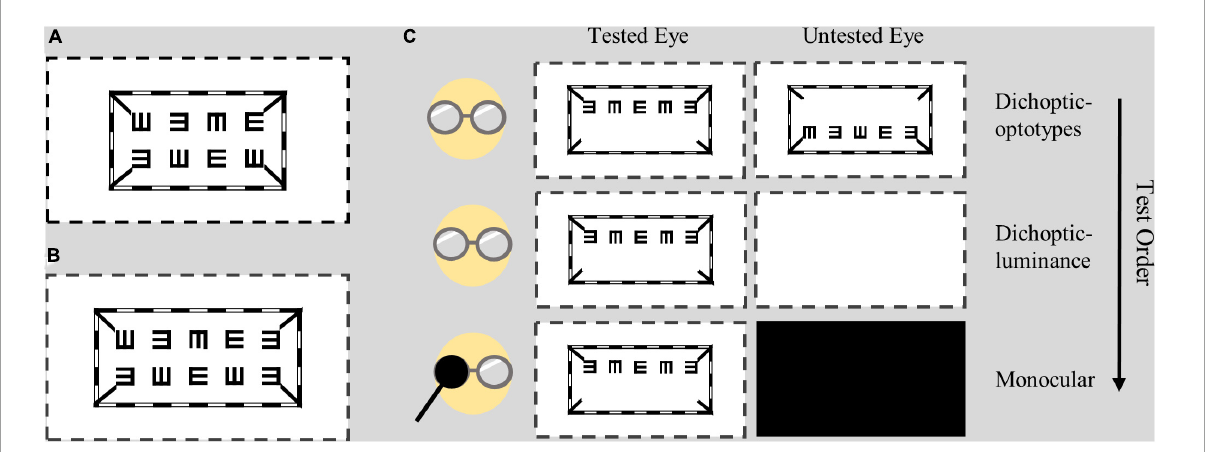
FIGURE1 Design of the dichoptic visual acuity chart. Two lines of E letters were presented to different eyes, while the envelope and four short lines were presented to both eyes. (A) In Experiment 1, each line had four letters with a letter representing 0.025 logMAR. (B) In Experiment 2, each line had five letters with a letter representing 0.02 logMAR. (C) Test conditions and test order. Subjects wore polarized glasses during all test conditions. The dotted lines indicate the margin of the